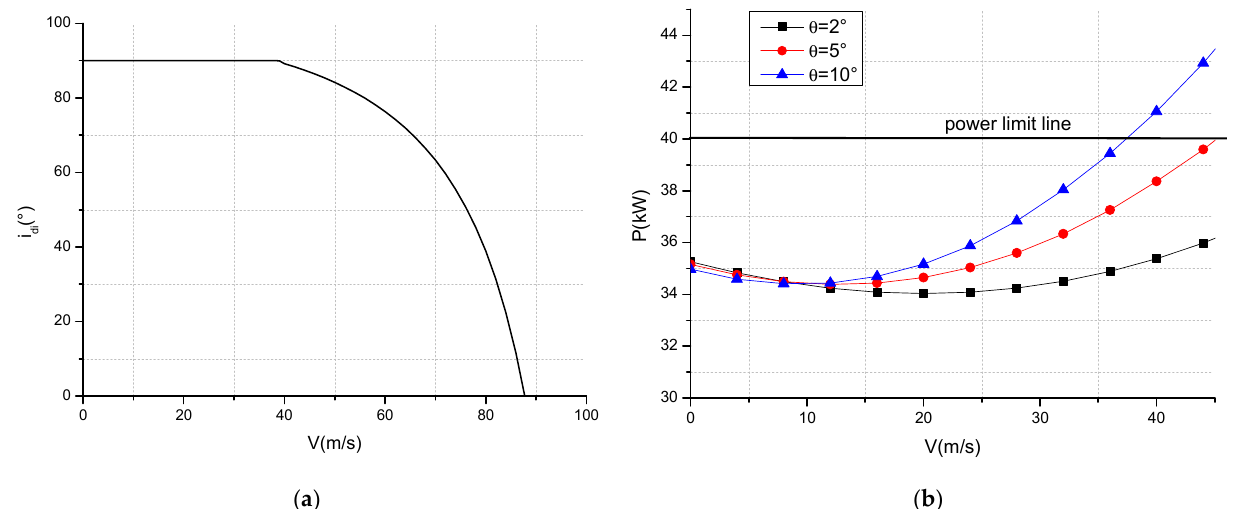
Figure 8. Results of the calculation of the transition corridor calculation based on power limitation. ( a ) Deflection angle of ducted lift-increasing system’s force. ( b ) Power curves of different attitude angle.